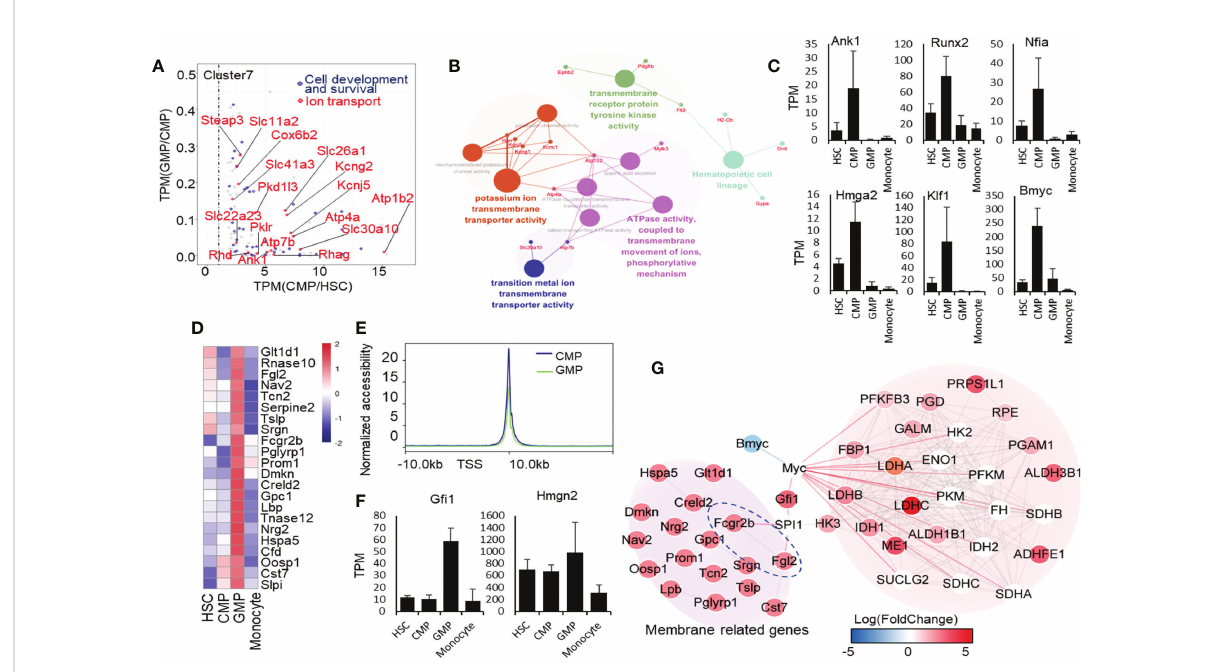
FIGURE 4 Transcriptional regulatory signatures in CMP and GMP developmental stages. (A) Dot plot of CMP highly expressed genes. The red color indicates the genes enriched in ion transport, and the blue color indicates the genes enriched in cell development and survival. (B) Network of ion-transport – related genes, which are highly expressed in mouse CMPs. (C) Selectively high expression of transcription factors in the CMP stage. (D) Heatmap of genes related to extracellular region part (GO:0005576). (E) The line chart shows the average intensity of TSS in mouse GMPs and CMPs. (F) High expressions of transcription factors selectively in the GMP stage. (G) Molecular network of membrane receptor-TF- metabolism regulated